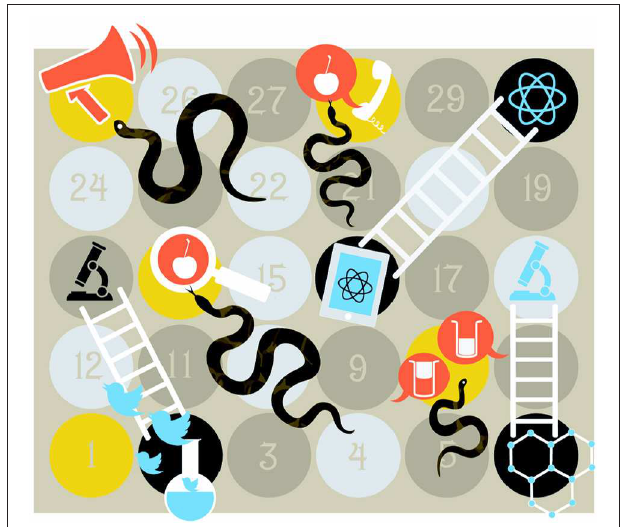
FIGURE 1 | Playing the snakes and ladders of climate science communication. The snakes on the board represent the poor dissemination of scientific knowledge by some main-stream media outlets leading to an ill-informed public through mechanisms including (but not limited to); 8: misinterpretation of science concepts by the media; 14: cherry picking of information; 25: sensationalism; and 28: oversimplification of information. The ladders represent the elevation of robust scientific climate evidence through mechanisms including (but not limited to); 2: scientists using social media platforms, such as Twitter; 6: capitalizing on academic networks to share teaching tools, and 16: the development of science education